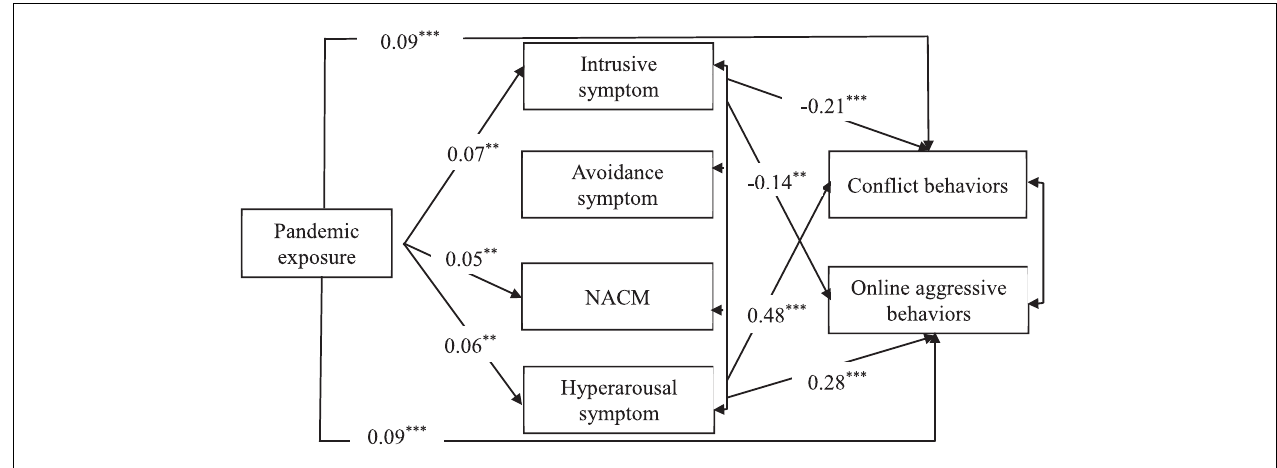
FIGURE 1 | The parsimonious path model of PTSD. *** p < 0.001, ** p < 0.01, NACM, negative alterations in cognition and mood.